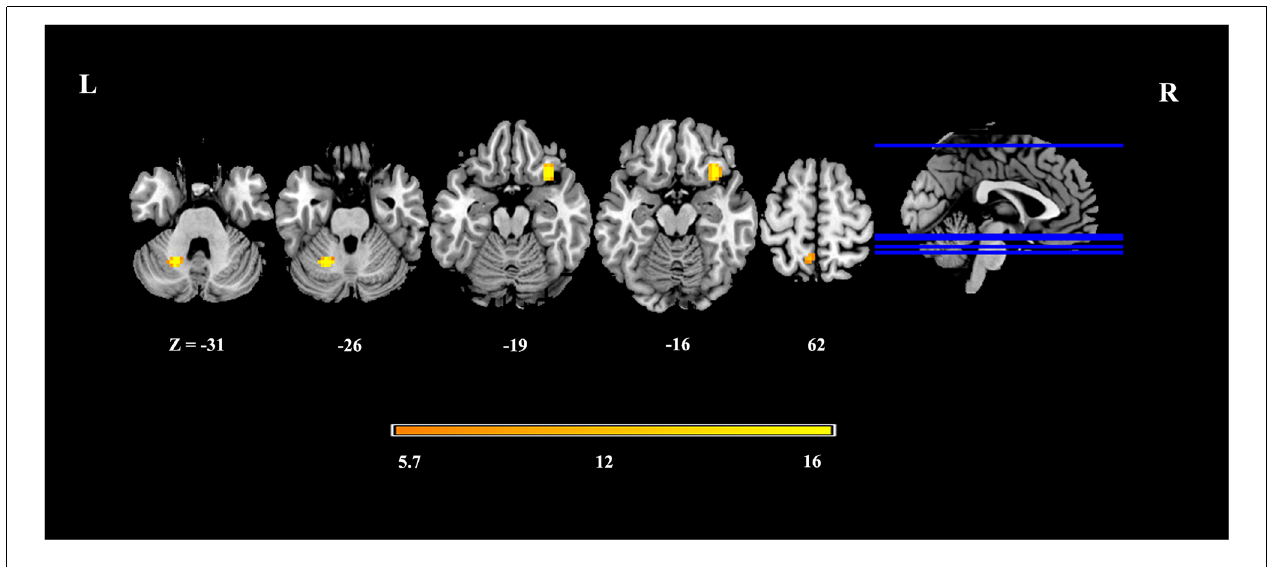
FIGURE 2 | Altered dynamic GS topography in AUD